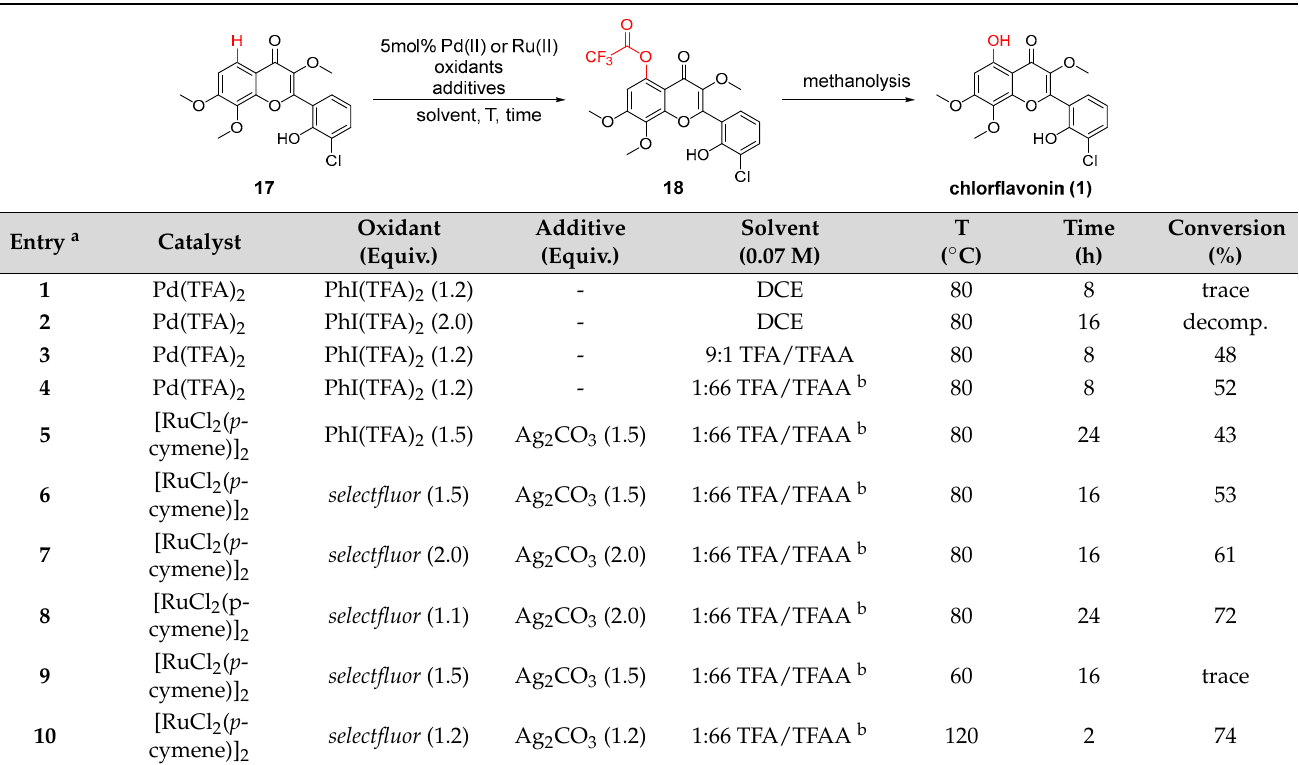
Table 1. Optimization of ortho -C(sp 2 )-H-hydroxylation of 3 ′ -methoxyflanonol 17